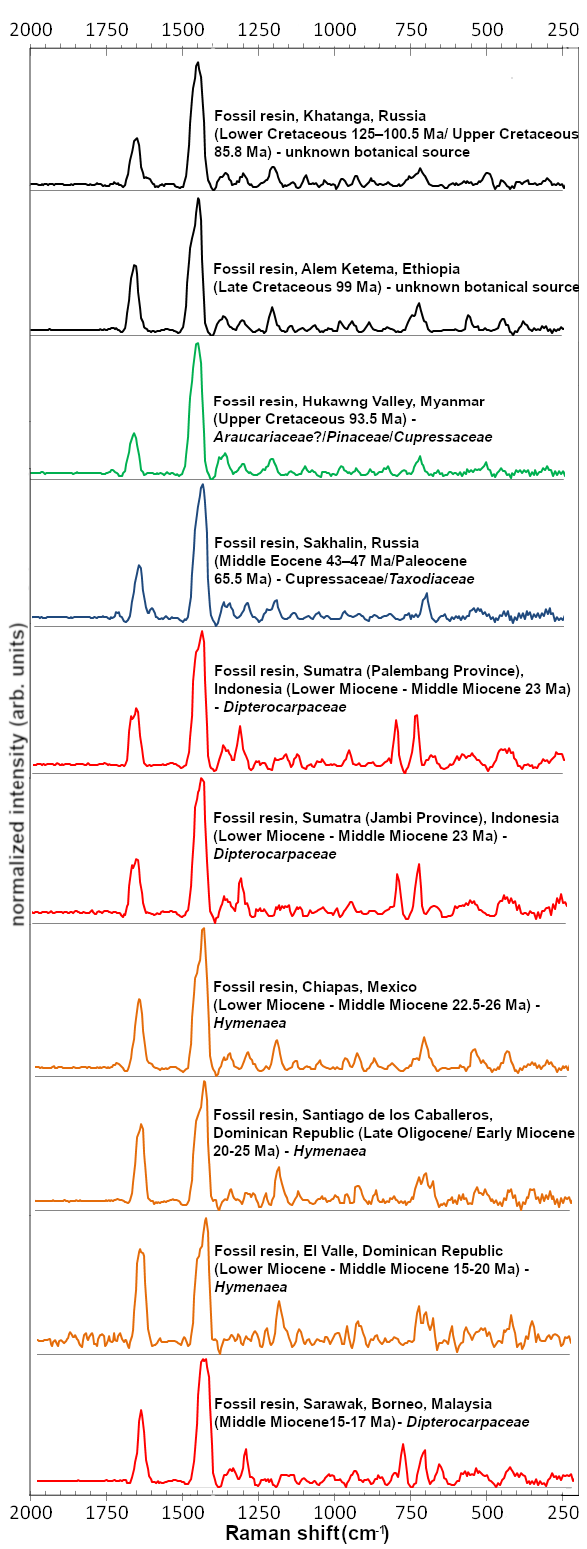
Figure 6. Raman spectra of fossil resins, arranged from the oldest to youngest, collected with hand-held equipment. Fossil resins of a similar botanical source have been underlined through the use of specific colour lines.